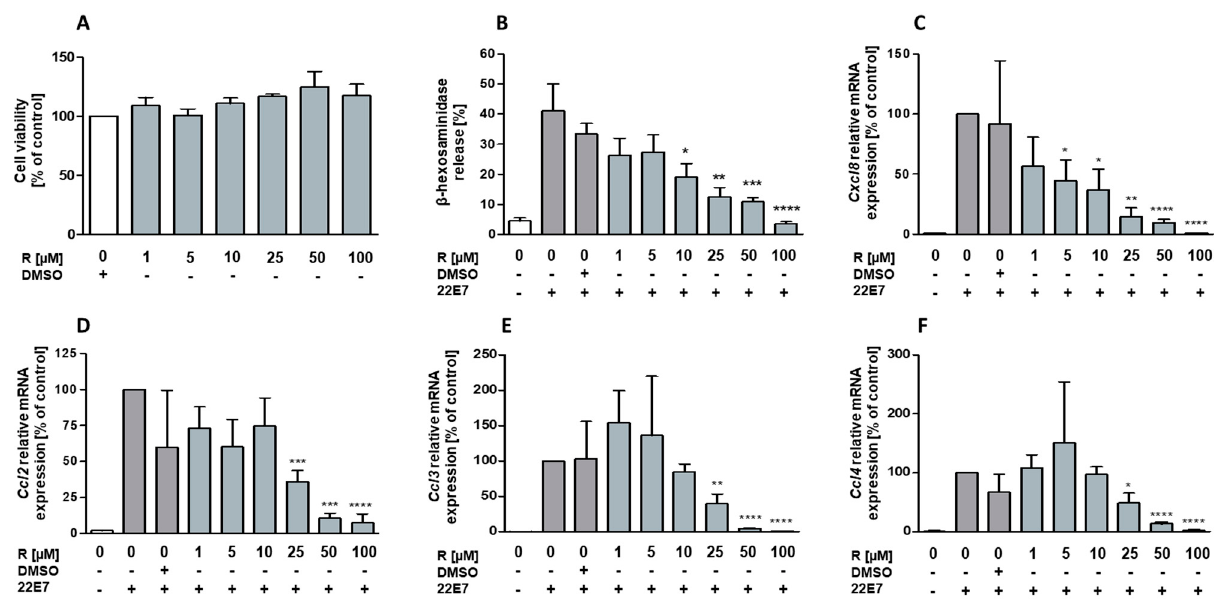
Figure 1. Cell viability, degranulation, and chemokine expression in human intestinal mast cells (hiMC) following treatment with resveratrol. Evaluation of cytotoxic effects of resveratrol on hiMC ( A ). Cells/well were incubated with 1, 5, 10, 25, 50, and 100 μ M of resveratrol and the corresponding DMSO control for 24 h. After incubation, living cells in percent of the DMSO control is shown ( n = 3). Release of β -hexosaminidase by hiMC ( B ) ( n = 6) and mRNA expression of Cxcl8 ( C ) ( n = 4), Ccl2 ( D ) ( n = 6), Ccl3 ( E ) ( n = 6), and Ccl4 ( F ) ( n = 6). Cells were incubated with 1–100 μ M of resveratrol for 60 min prior to stimulation by Fc ε RI crosslinking using 100 ng/mL of monoclonal antibody (mAb) 22E7 for 90 min. Controls were treated with the corresponding concentration of the vehicle DMSO. Values are mean ± SEM. * p < 0.05; ** p < 0.01; *** p < 0.001; **** p < 0.0001 compared to induced control treated with DMSO.